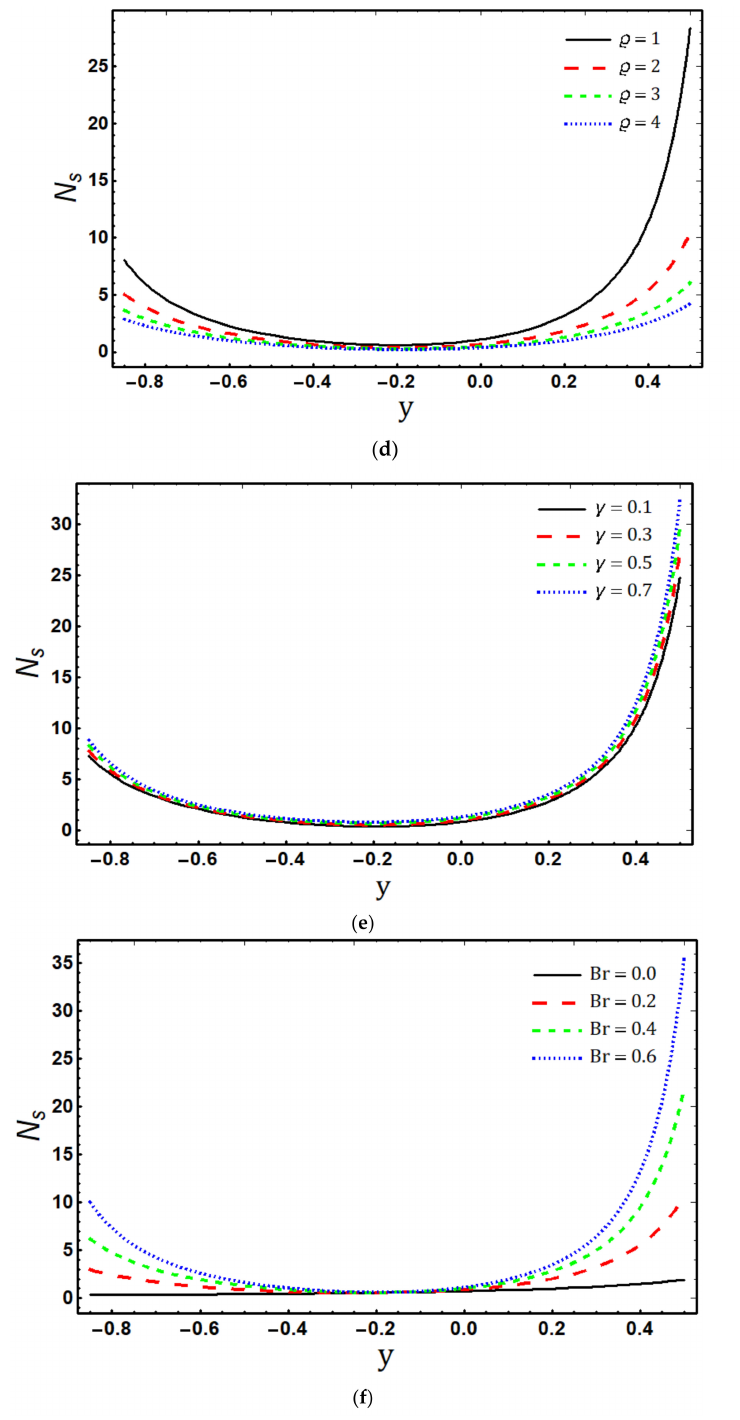
Figure 5. ( a ): Effects of Ha on N s , while other parameters are b 1 = 0.3, b 2 = 0.5, x = 0.5, l = 1, ζ 1 = − 0.5, ζ 2 = − 0.4, U HS = − 0.75, Θ = 1.5, Φ = π /3, α = π /3, m e = 3, B 1 = 2, M 1 = 1, B 2 = 0.02, G t = 0.6, G a = 1.5, Sc = 1.5, M 2 = 1.5, γ = 0.6, Br = 0.5, (cid:36) = 1. ( b ): Effects of B 1 on N s , while other parameters are b 1 = 0.3, b 2 = 0.5, x = 0.5, l = 1, ζ 1 = − 0.5, ζ 2 = − 0.4, U HS = − 0.75, Θ = 1.5, Φ = π /3, α = π /3, Ha = 1, G t = 0.6, M 1 = 1, B 2 = 0.02, m e = 3, G a = 1.5, Sc = 1.5, M 2 = 1.5, γ = 0.6, Br = 0.5, (cid:36) = 1. ( c ): Effects of B 2 on N s , while other